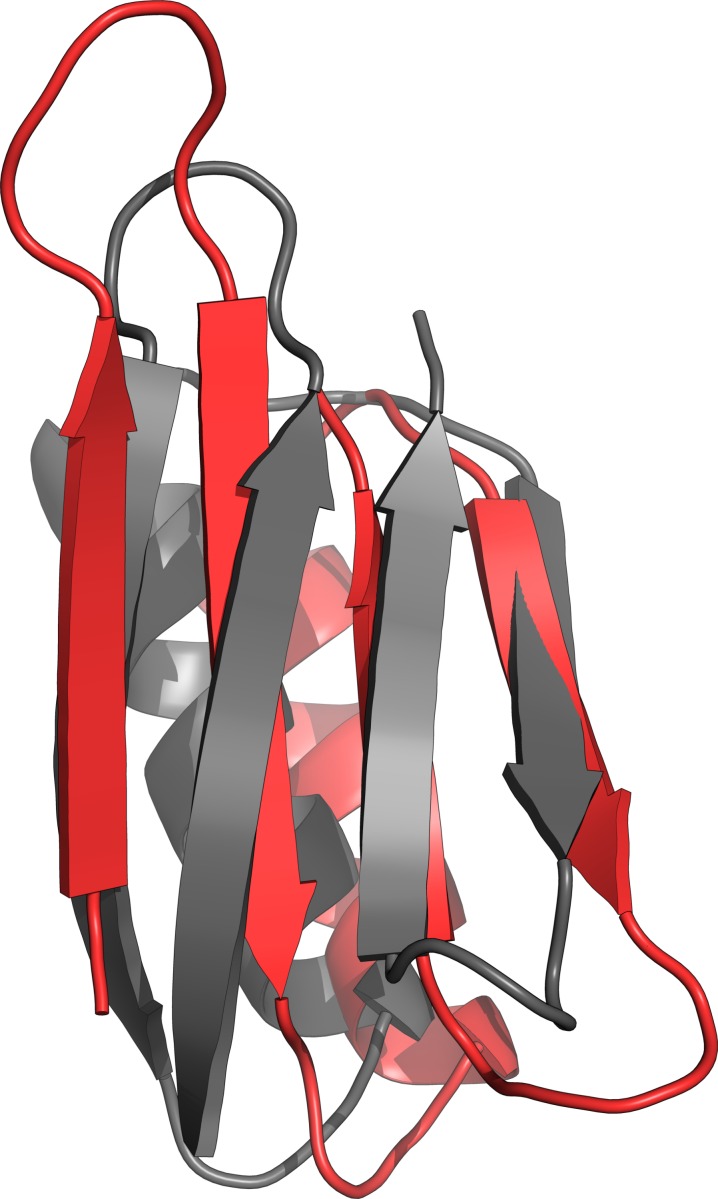
Local energy-minimum of Protein-G.Crystal structure (grey) and local energy-minimum conformation (red) of Protein G. Figure made with PyMOL (Schrödinger LLC, 2010).